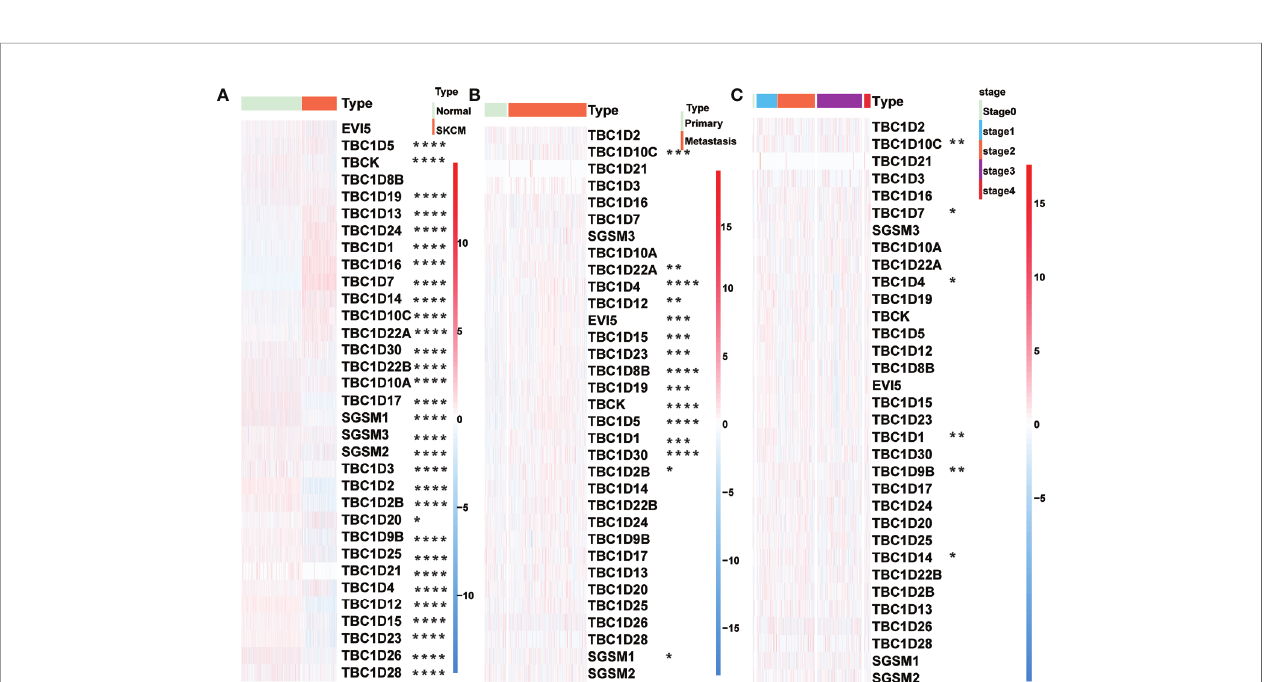
FIGURE 2 | Relationship between TBCs mRNA expression and clinical features in melanoma. The heat maps based on clustering analysis according to the subgroups exhibited the differential expression patterns of TBCs (Tumor type: Normal vs Tumor (A) , Tumor type: Primary vs Metastasis (B) and Tumor stage: stage0 vs stage1 vs stage2 vs stage3 vs stage4 (C) . *p < 0.05, **p < 0.01, ***p < 0.001, **** <